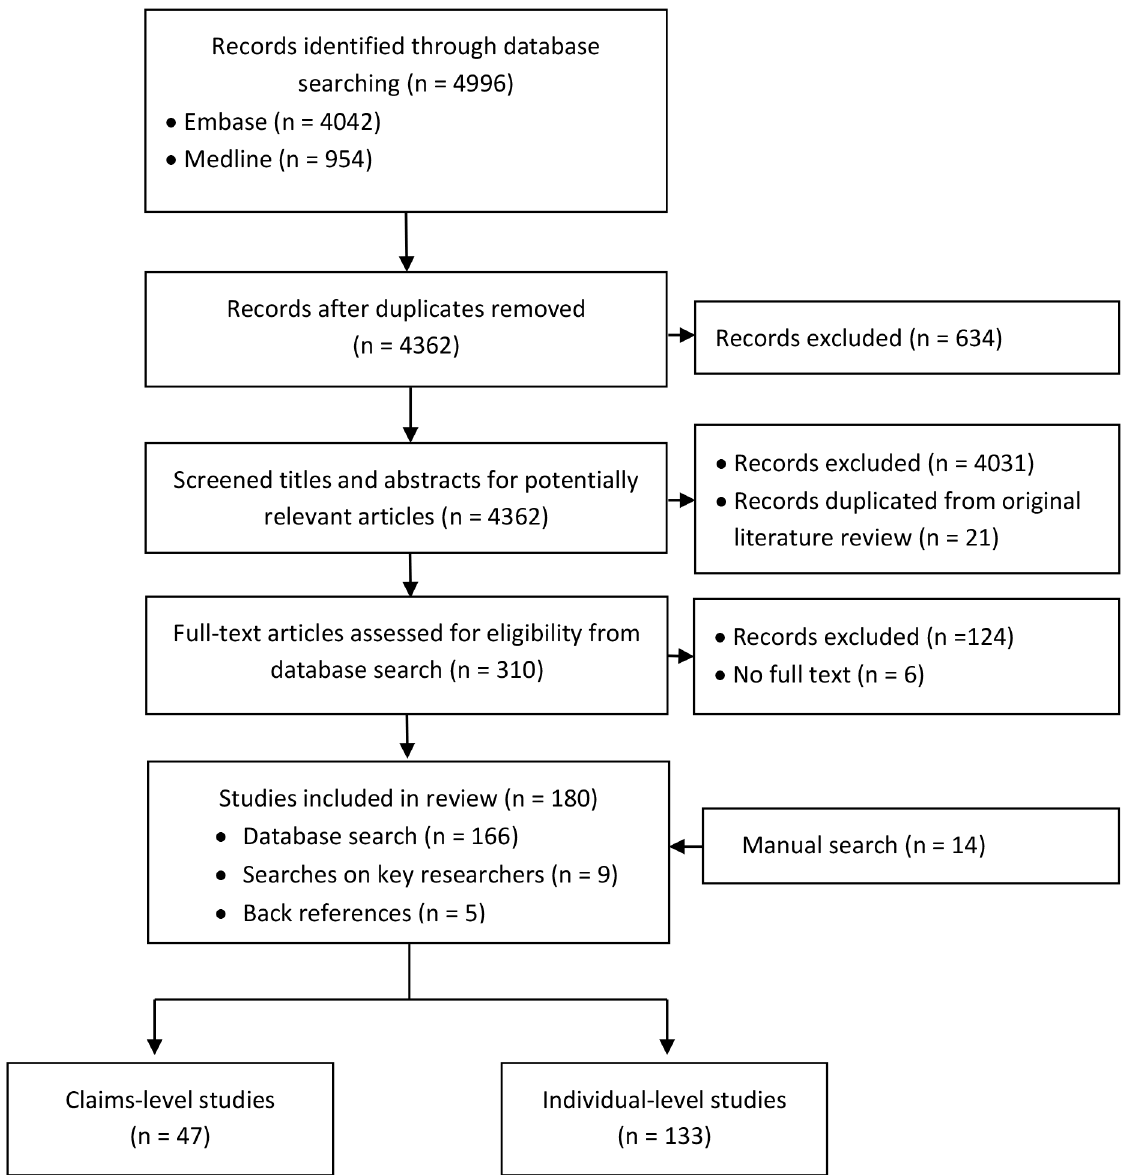
Figure 1: Identification of studies included in the systematic